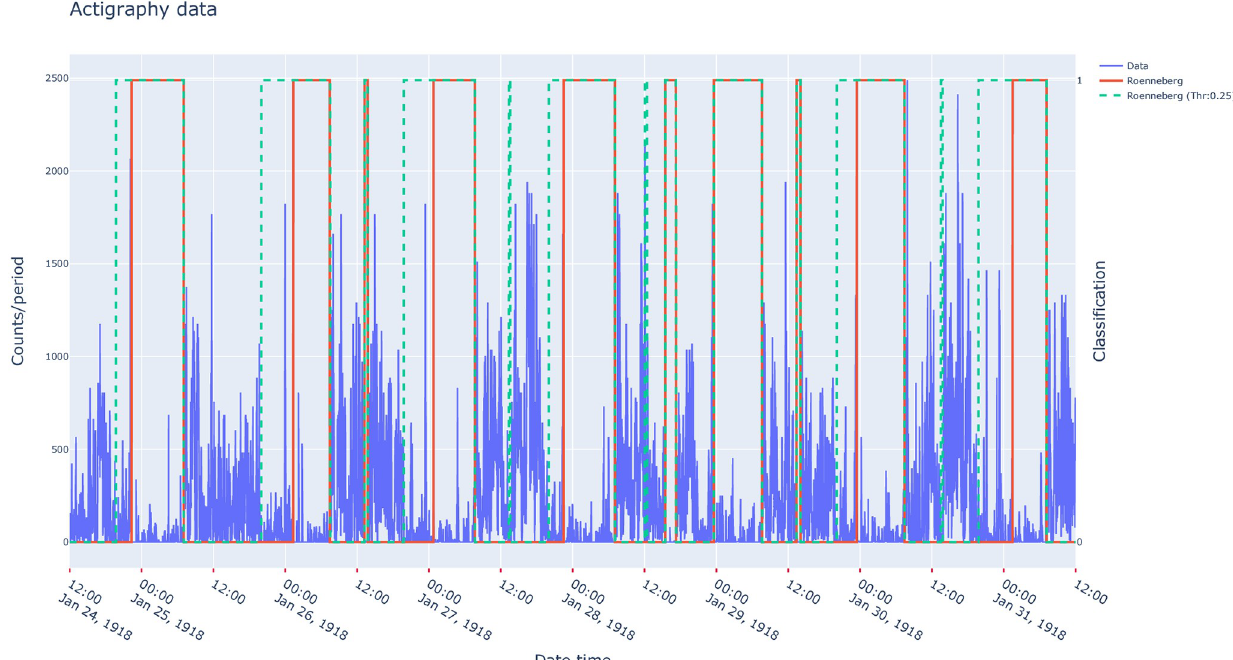
Fig 4. Visualization example of actigraphy data, overlaid with periods scored as “active” (0) or “rest” (1) by Roenneberg’s algorithm [33] for two different settings (full line: Default parameter values, dash line: With a threshold set at 0.25 of the activity trend).